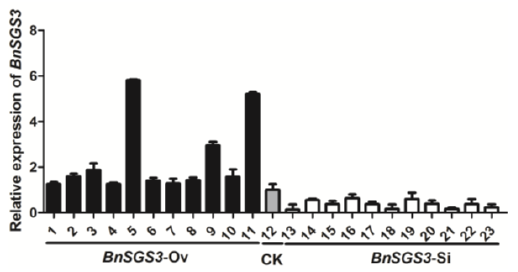
Figure 3. Relative expression levels of BnSGS3 in single BnSGS3 -overexpressing ( BnSGS3 -Ov) oilseed rape plants (1–11), non-transgenic oilseed rape plant (12) and single BnSGS3 -silenced ( BnSGS3 -Si) oilseed rape plants (13–23).